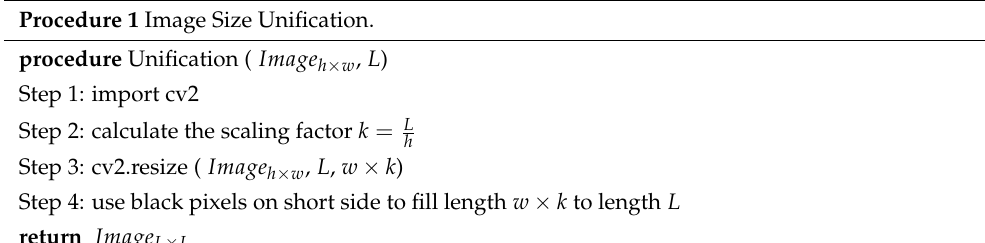
Table 2. Procedure of image size unification.